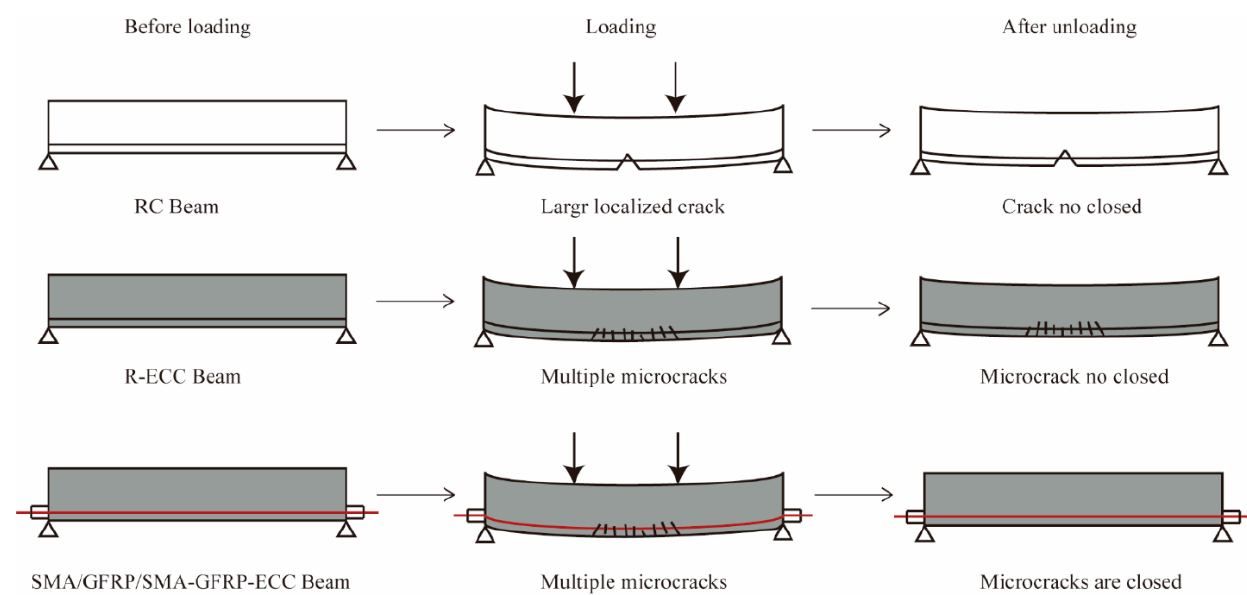
Figure 4. Schematic drawing of crack changes.